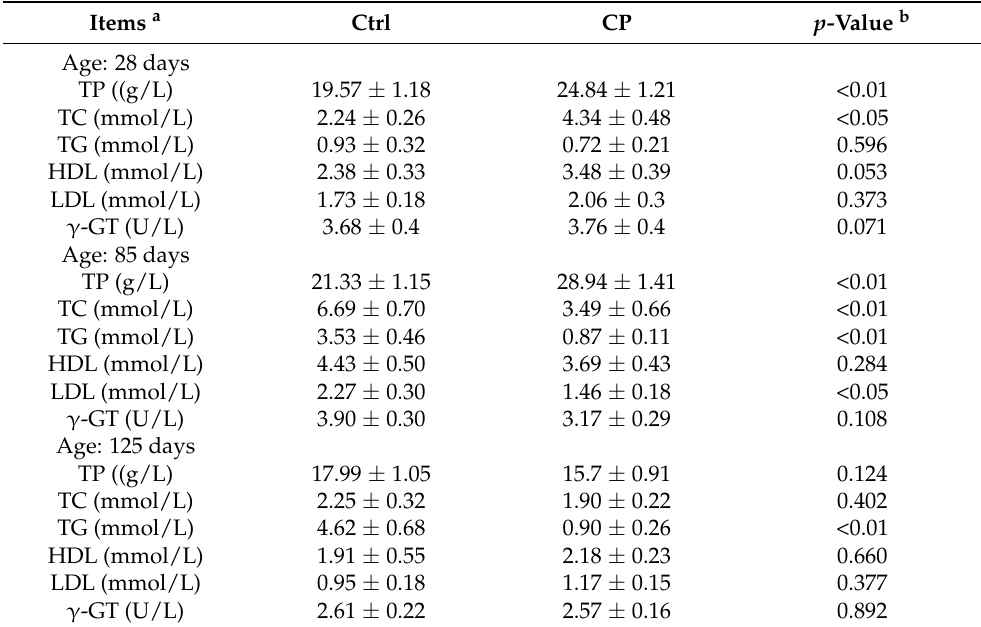
Table 3. Effects of compound probiotics on serum biochemical indices of ducks.